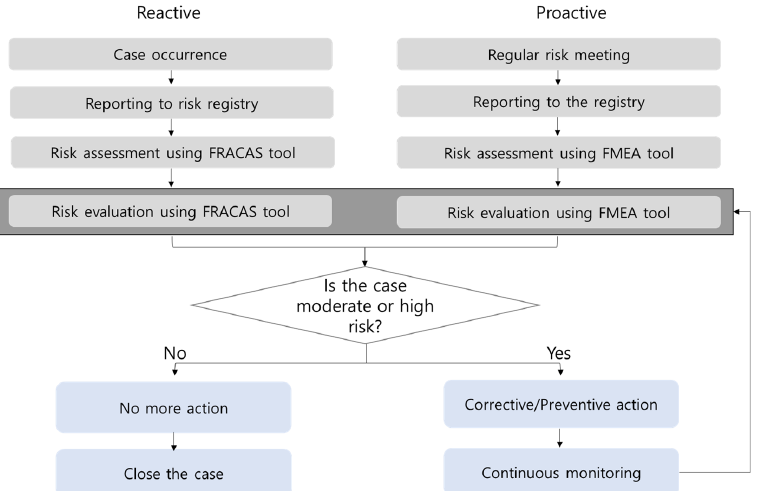
Figure 1. Concept flow diagram for the risk registry and management system based on FMEA and FRACAS for total testing process. FMEA, failure mode and effects analysis; FRACAS, failure re- porting, analysis, and corrective action system.